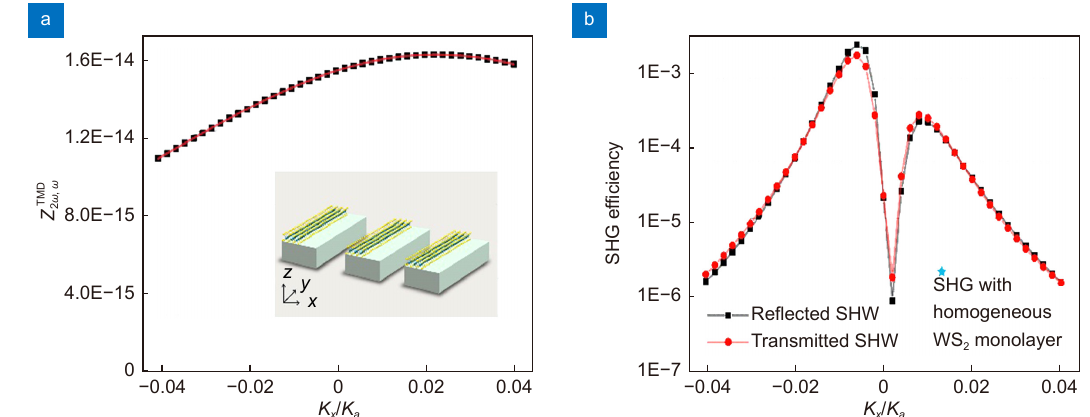
Fig. 3 | Spatial overlap coefficient and SHG efficiency with a patterned WS 2 on top of the photonic grating slab. ( a ) The K x dependent spatial overlap coefficient . ( b ) The K x dependent SHG efficiency monitored at the reflected (top) and transmitted (bottom) side, respectively. The blue star is a reference point for showing the maximum SHG efficiency achieved in the case with homogeneous WS 2 monolayer. The FW is incident from the top side of the grating, and the intensity of FW is set to be 0.1 GW/cm 2